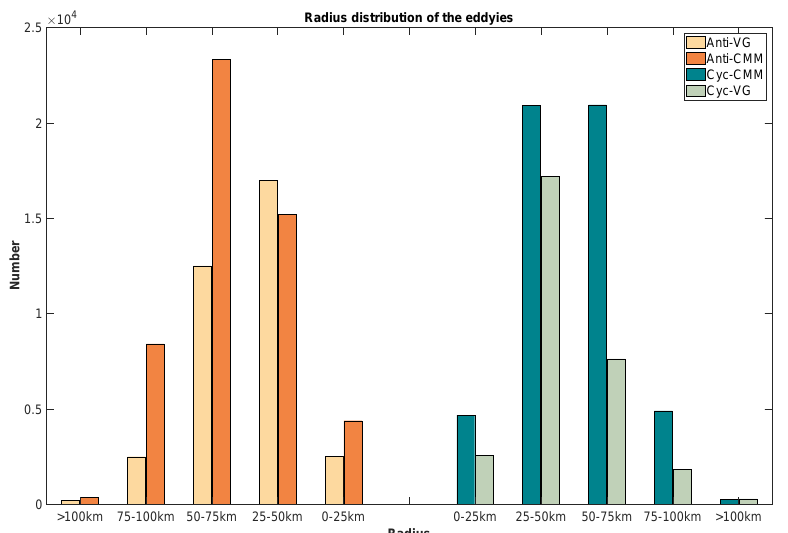
Figure 6. Radius distribution of the eddies detected with the two methods in the BSs during